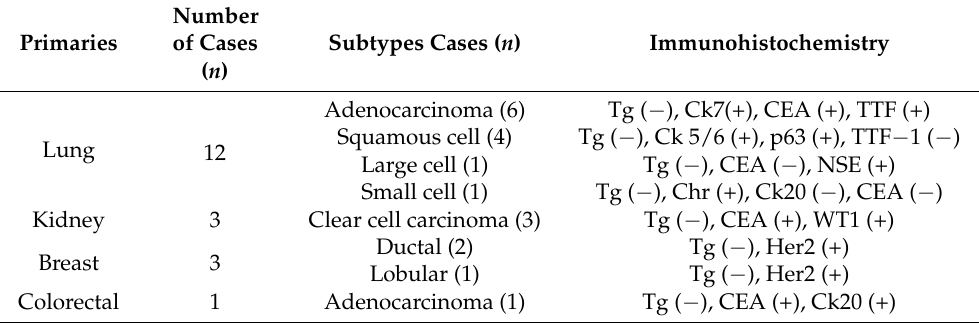
Table 1. Histological and immunohistochemical characteristics of secondary tumors of the thyroid gland. Number Primaries of Cases Subtypes Cases ( n ( n )